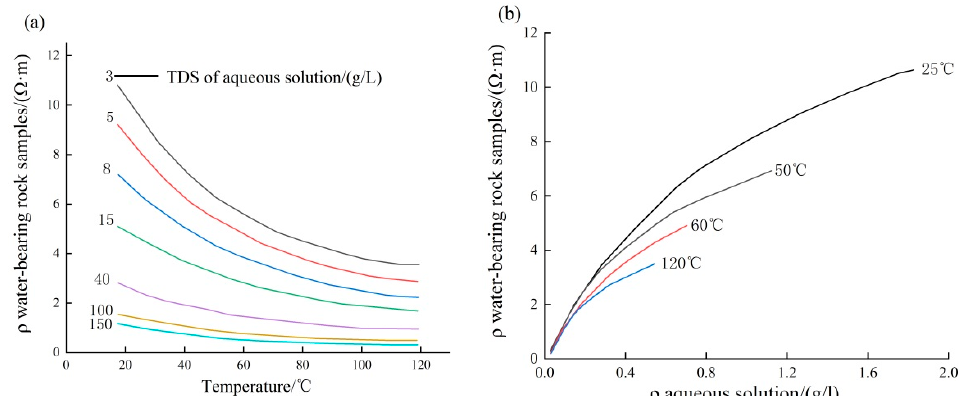
Figure 7. Relationships among the resistivity of water-bearing rock samples ( a ), temperature, and the TDS content of aqueous solutions ( b ). TDS content of aqueous solutions ( b ).